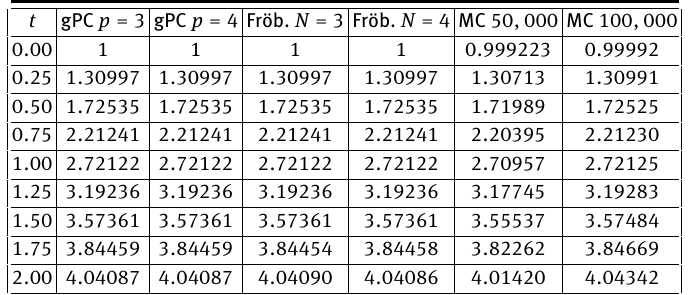
Table 5: Approximation of V [ X ( t )] . Example 4.1, assuming dependent random data.